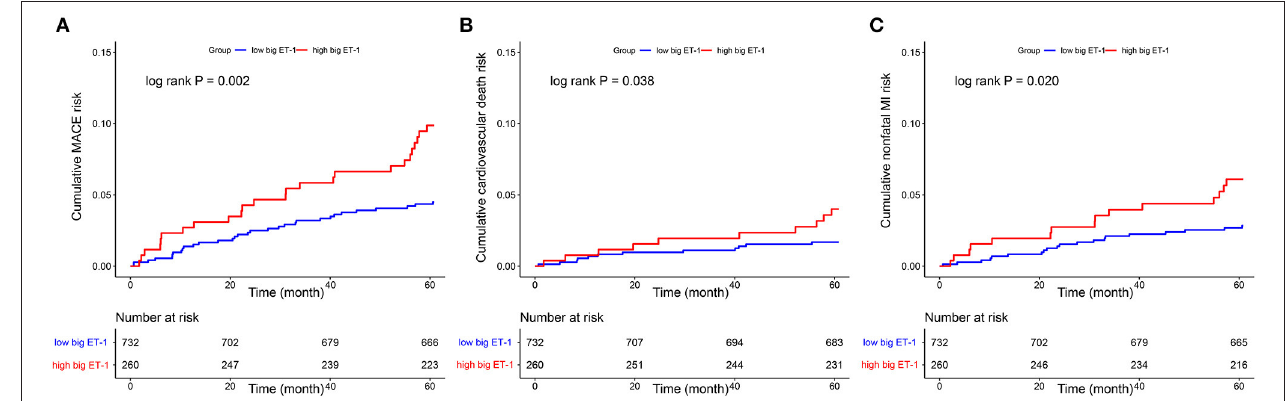
FIGURE 2 | Kaplan–Meier curves showed cumulative event risk of MACE (A) , cardiovascular death (B) , and nonfatal MI (C) . MACE, major adverse cardiovascular event; MI, myocardial infarction; ET, endothelin.